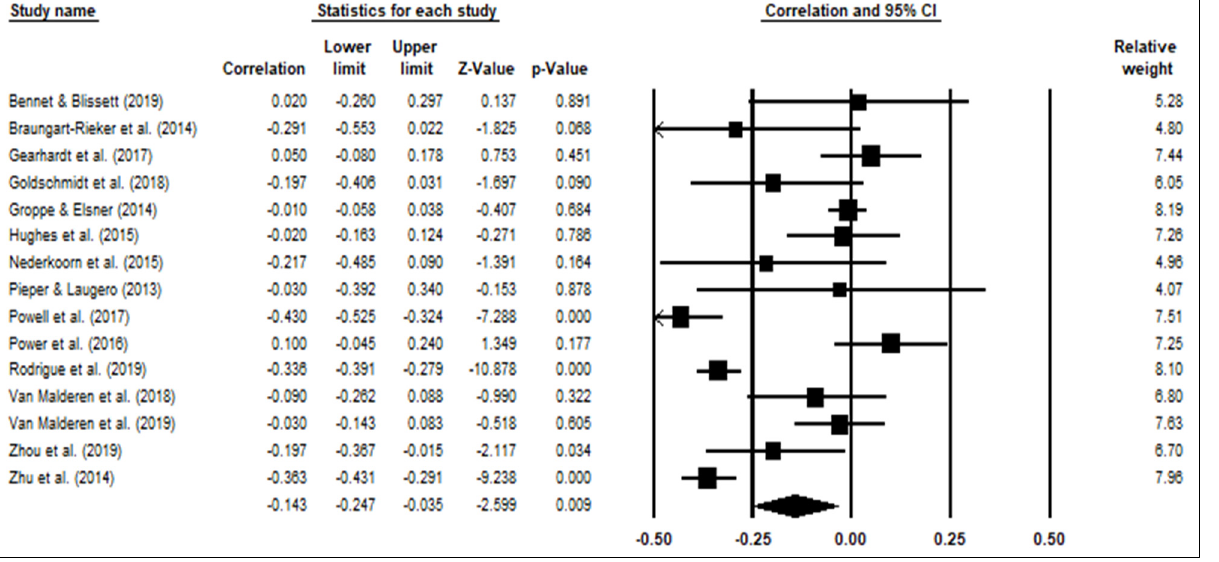
Figure 2. Random effects correlations, 95% confidence intervals, forest plot, and relative weight of overall executive functioning on disinhibited eating.